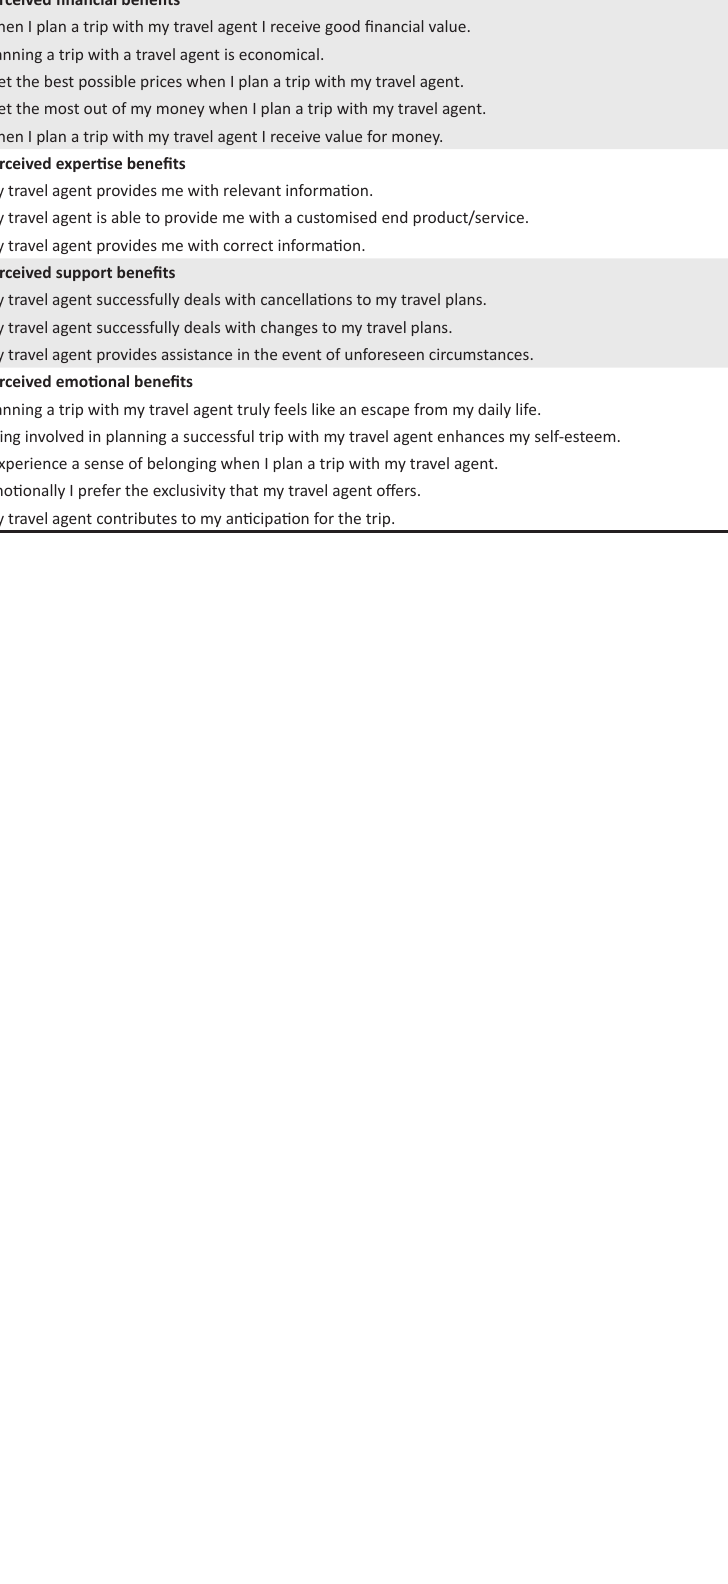
TABLE 1-A3: Final items of the study.